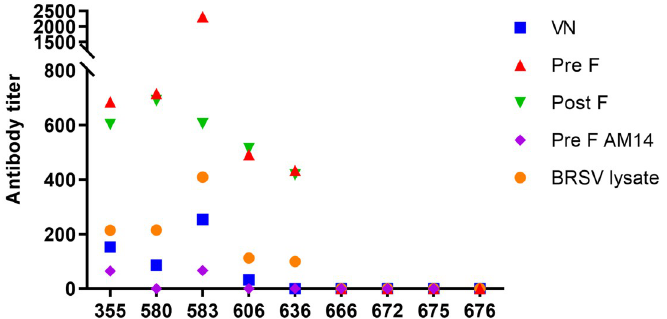
Fig 10. BRSV-specific serum antibodies in na ï ve cows and in cows infected with BRSV four years earlier. BRSV- neutralising antibodies (VN), BRSV-Pre F-specific IgG1 antibodies (Pre F) and BRSV-Post F-specific IgG1 antibodies (Post F), AM14-competing antibodies reactive to Pre F (AM14) and BRSV-specific IgG1 (BRSV lysate) 3 weeks before a BRSV (re)infection (March 2020). Animal 355–636 had been infected four years earlier (January 2016).